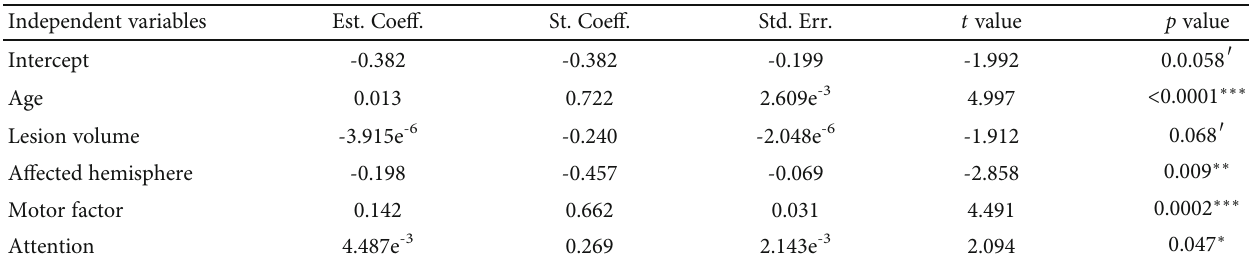
Table 2: Signi fi cant regression